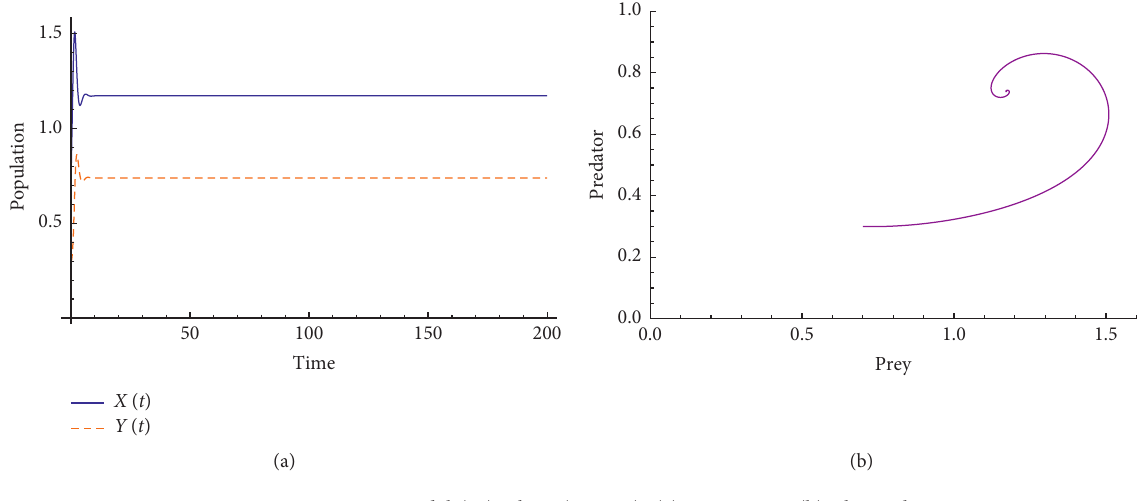
Figure 1: Dynamics model (31) when ( σ � 0 . 0 ) : (a) time series; (b) phase plane.